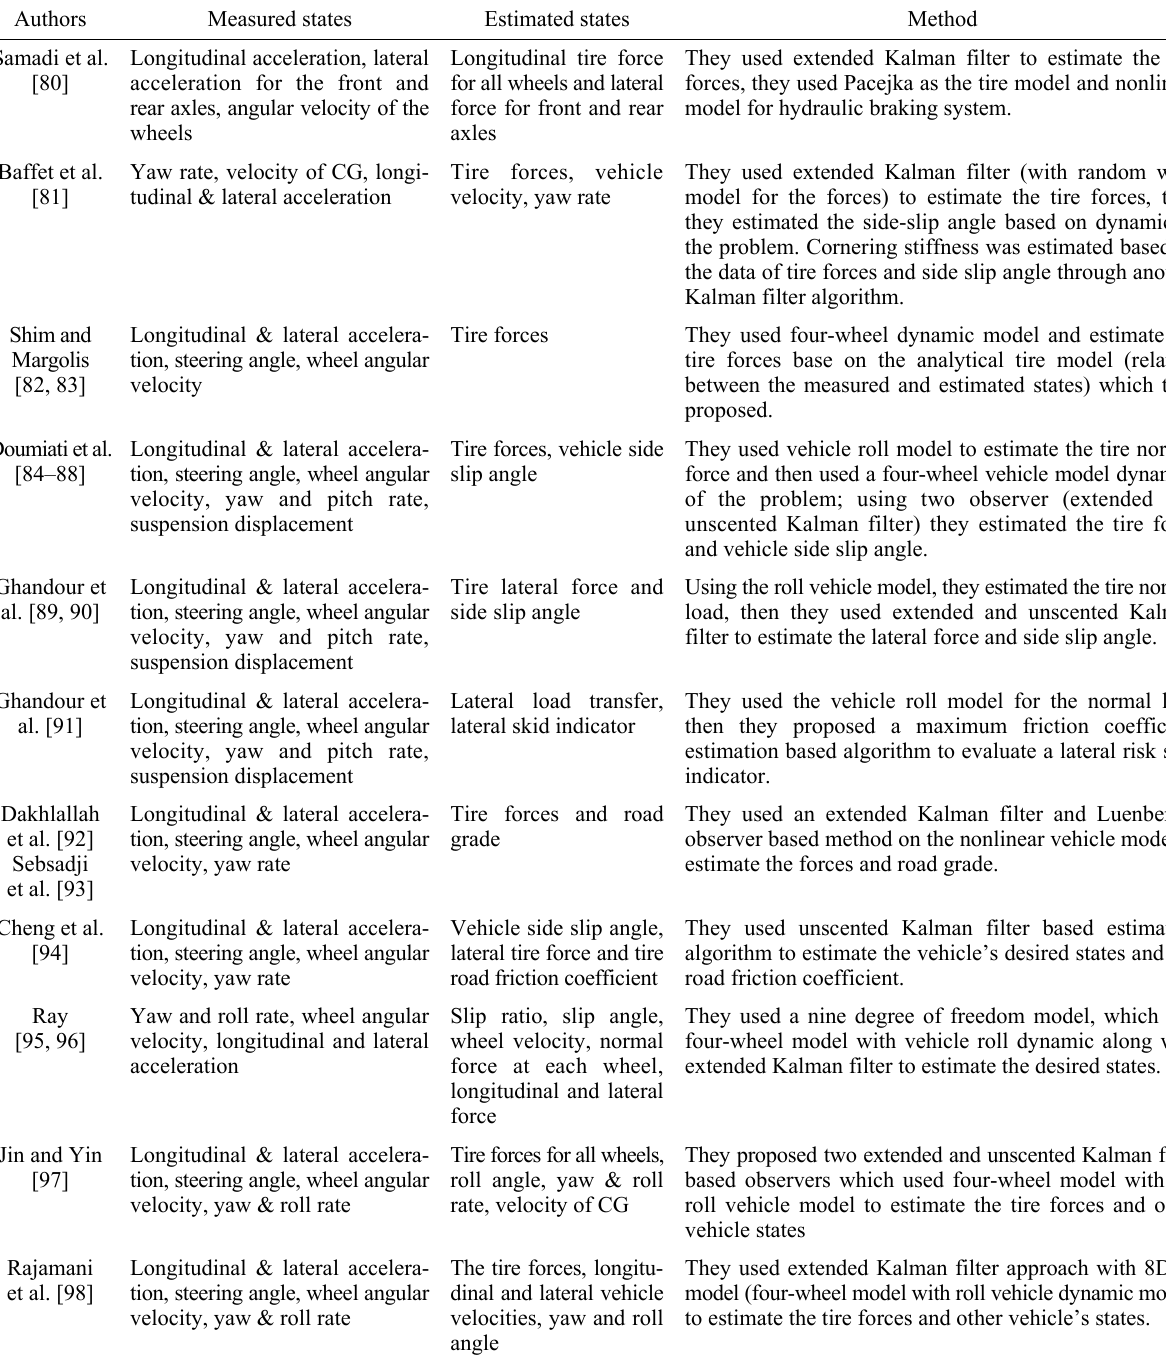
Table 3 Some selective studies which have used four-wheel vehicle model.